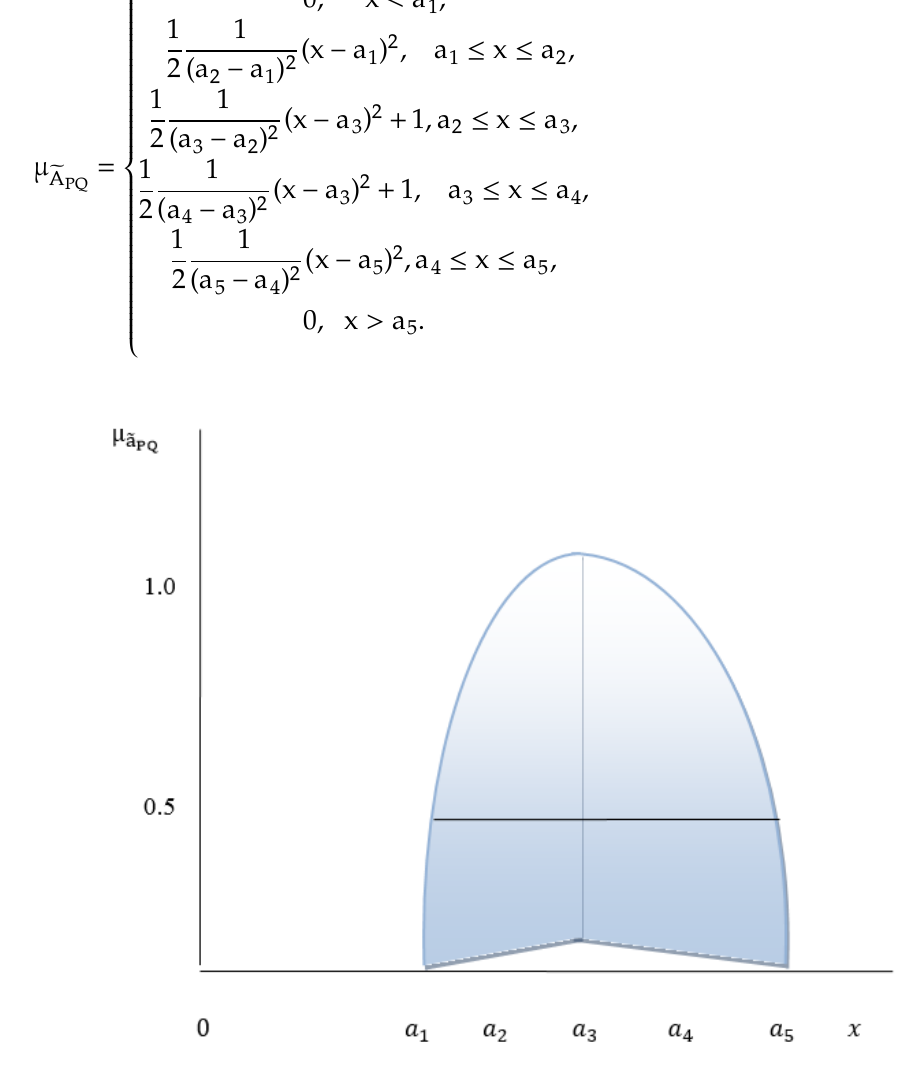
Fig. 1. Graphical representation of a Piecewise Quadratic Fuzzy Number